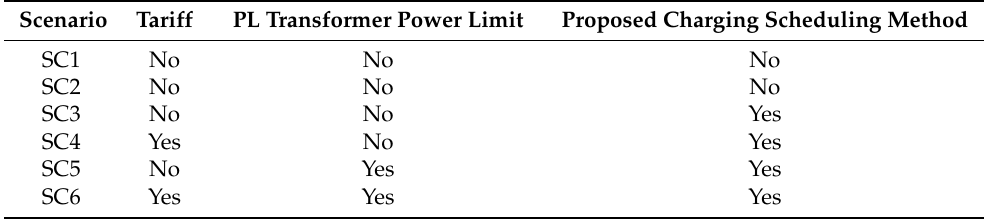
Table 3. Examined operation